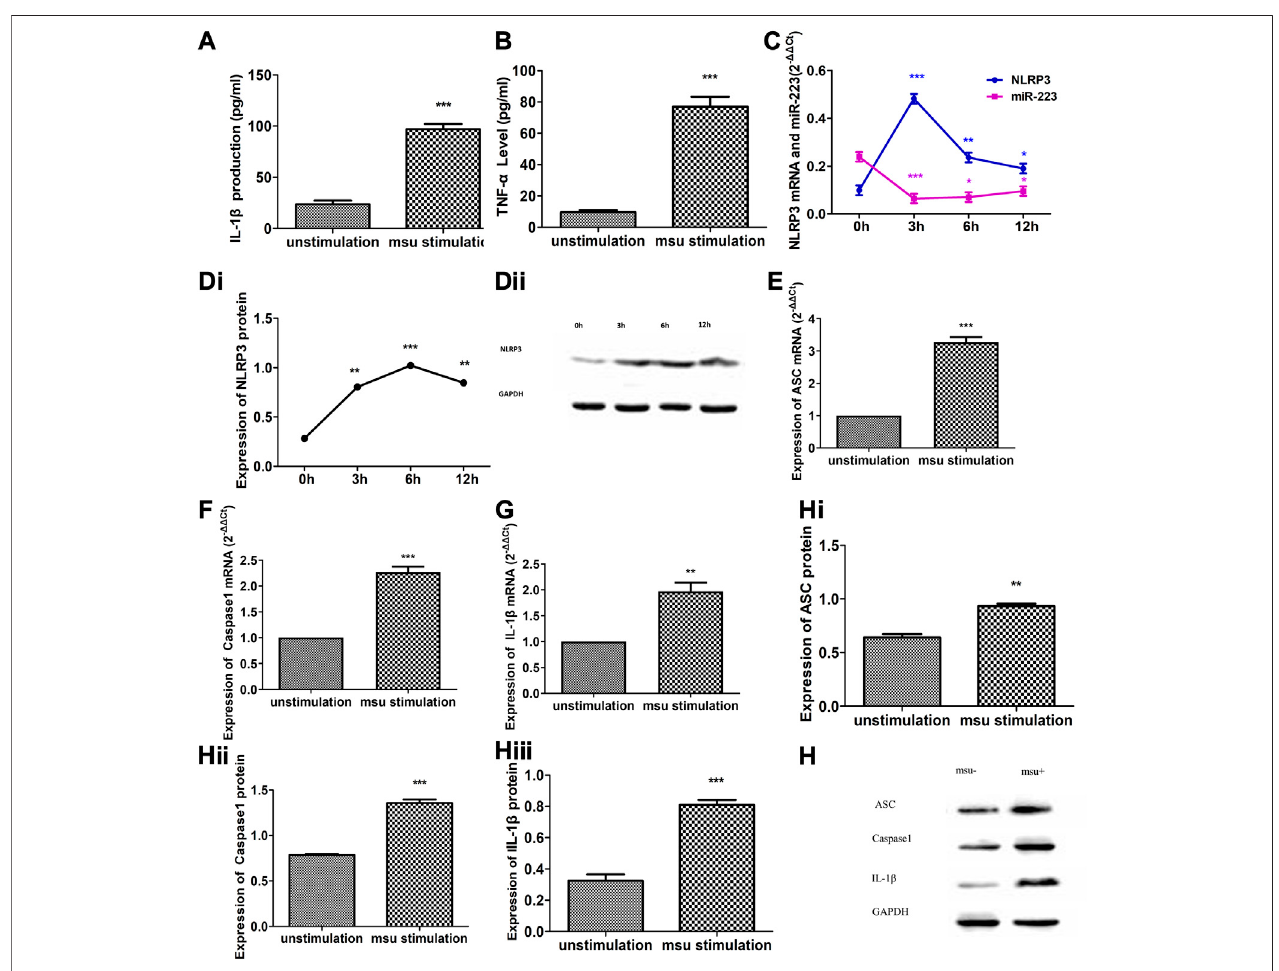
FIGURE 2 | Altered expression ofmiR-223, NLRP3 in fl ammasome and cytokines in MSU crystal-induced RAW264.7 murine macrophage in fl ammation. (A, B) IL- 1 β and TNF- α levels were dramatically increased in cultural supernatants after RAW264.7 macrophages were treated with MSU for 6 h ( n (cid:2) 5). (C) Altered expression of NLRP3 mRNA and miR-223 upon stimulation of RAW264.7 cells in comparison with that of unstimulated control cultures ( n (cid:2) 5). NLRP3 mRNA up-regulation of approximately 4.88-foldafter MSU stimulation for 3 h, 2.39-fold after 6 h, and 1.92-fold after 12 h.MiR-223down-regulation ofapproximately 3.71-foldafter MSU stimulationfor3 h,3.39-foldafter6 h,and2.50-foldafter12 h. (Di,Dii) AlteredexpressionofNLRP3proteinuponstimulationofRAW264.7cellsincomparisonwiththat of unstimulated control cultures ( n (cid:2) 5). NLRP3 protein up-regulation of approximately 2.85-fold after MSU stimulation for 3 h, 3.62-fold after 6 h, and 2.99-fold after 12 h. (E – H) Altered expression of ASC, caspase-1 and IL-1 β mRNA and protein in RAW264.7 macrophages stimulated with MSU for 6 h * p < 0.05, ** p <